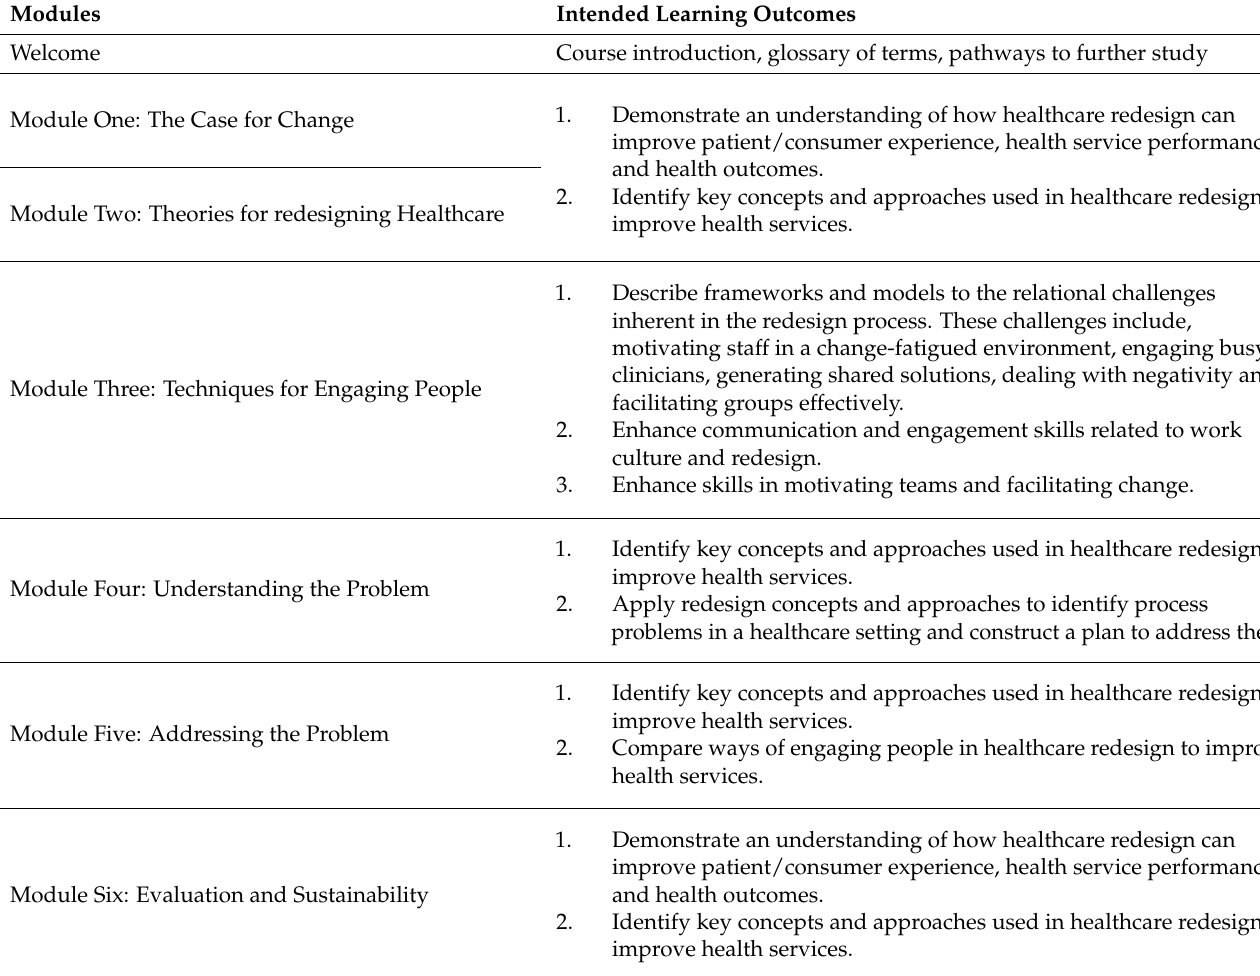
Table 1. Summary of Modules in the Healthcare Redesign